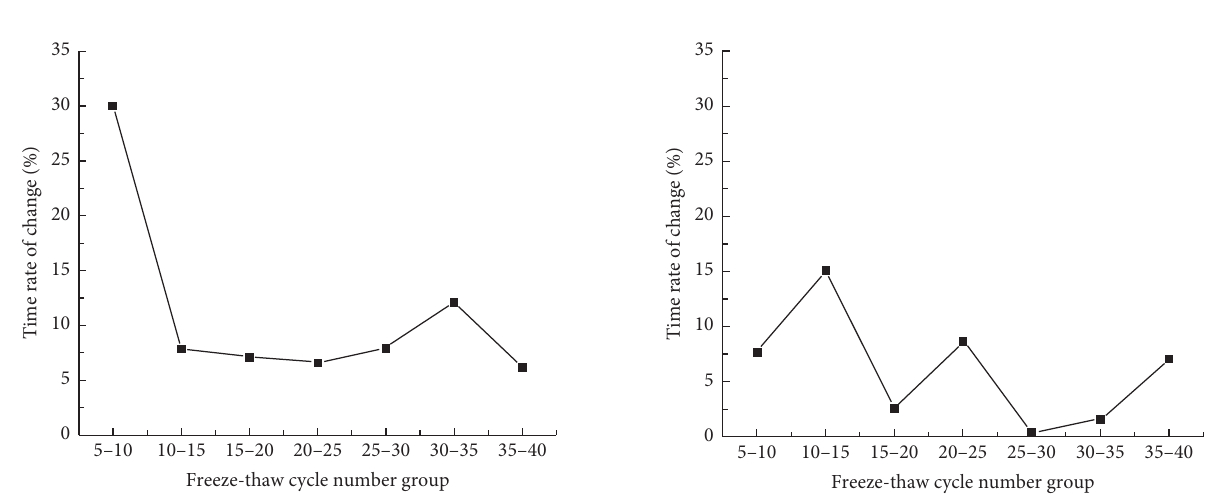
T = 107.5n 0.0014 – 106.6 r